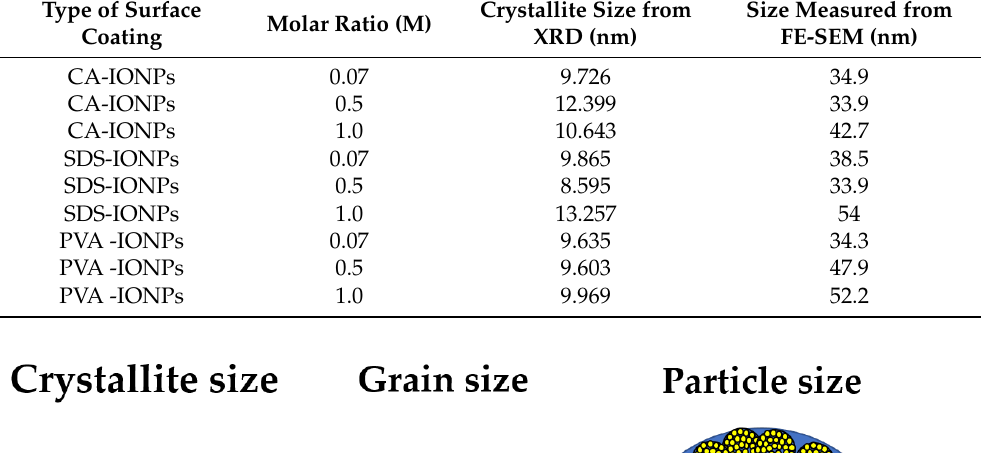
Table 1. List of surface-coated iron oxide nanoparticles with their respective crystallite sizes.